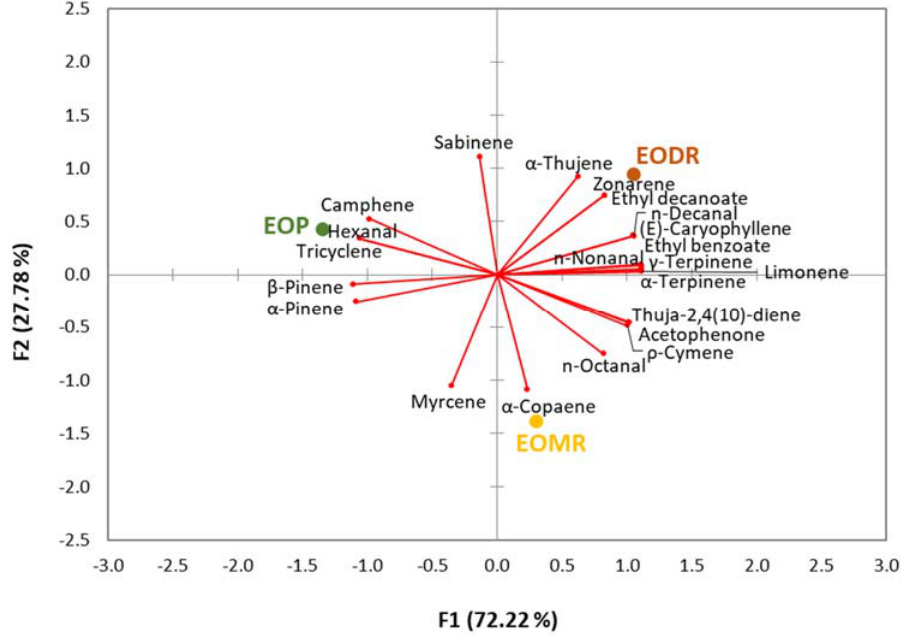
Figure 5. Principal components analysis (PCA) of the chemical composition profile of essential oils from crude organic propolis (EOP) and from its moist residue (EOMR) and dry residue (EODR). The data were represented as relative quantities for each essential oil; the tentative identification of the compounds present in the samples did not reach